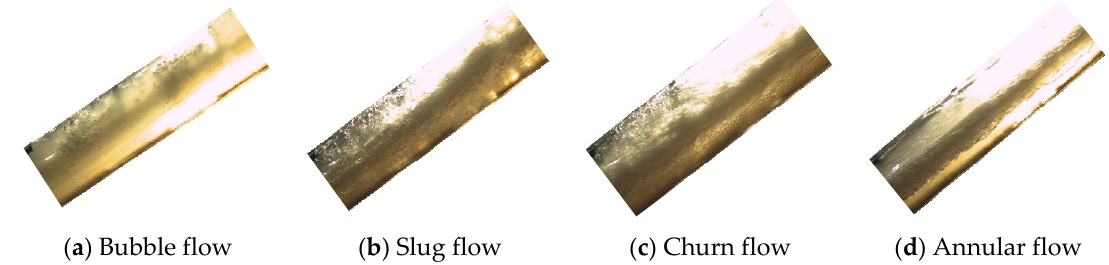
Figure 3. Flow pattern observed in the experiment at an inclination angle of 45°.